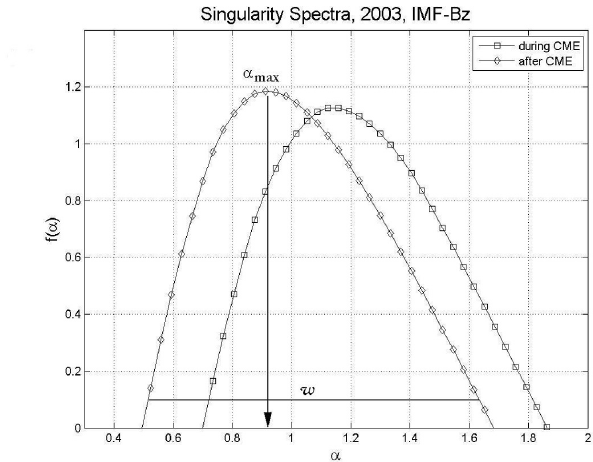
Fig. 4. Mean values of the singularity spectra, f (α) , for two cate- gories: with and without CME events.